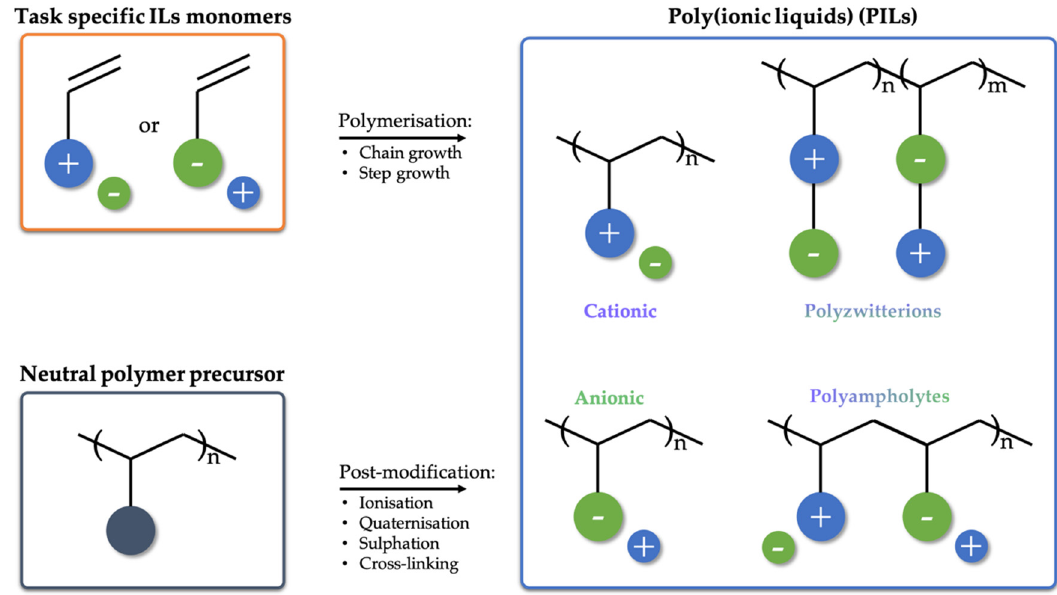
Figure 5. Poly(ionic liquids) synthesis via polymerization of task-specific IL monomers ( top-left ) and post-modification of polymeric precursors ( bottom-left ) yields similar polymeric structures based on their ionic composition: Cationic ( top- center ), anionic ( bottom-center ), polyzwitterions ( top-right ), and polyampholytes ( bottom-right ). Ions (small spheres) or ionic moieties (large spheres) are indicated with the positive (blue +, cation) or negative (green -, anion) symbol.